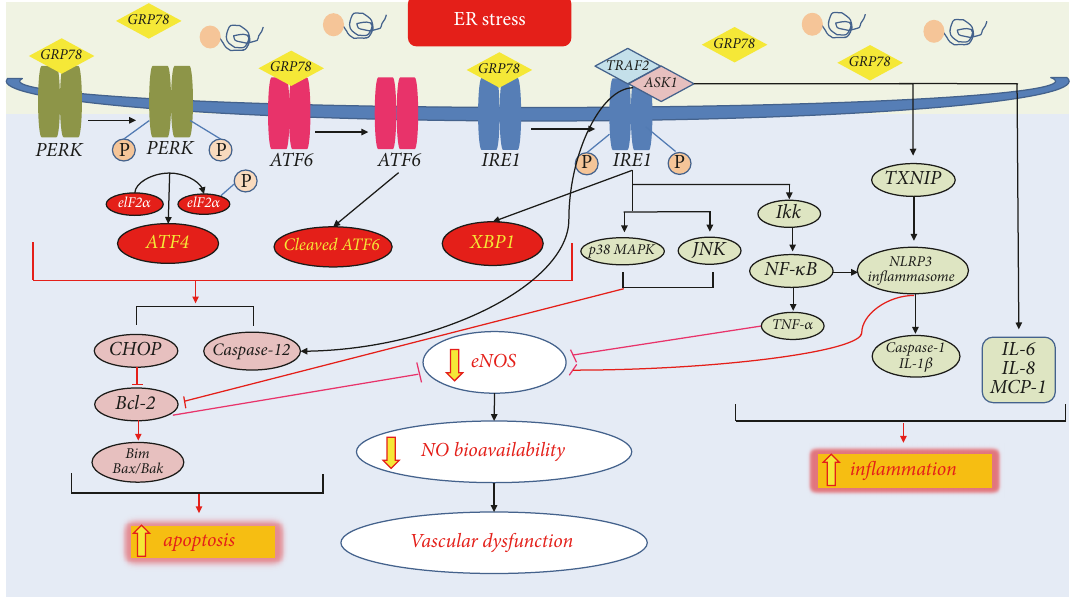
Figure 1: ER stress-mediated apoptosis and inflammation in cardiovascular disease . When prolonged ER stress occurs, activation of CHOP- mediated and JNK/p38 MAPK-mediated apoptosis signaling pathways regulate the Bcl-2 family, which controls the balance of pro- /antiapoptotic signaling, and ER stress-induced apoptosis signaling dampens eNOS expression with the increased oxidative stress. The IRE1 𝛼 /TRAF2/ASK1 complex also activates caspase-12 and ultimately induces cell apoptosis. Furthermore, ER stress-mediated NF- 𝜅 B-IKK activates NLRP3 inflammasome and mediates eNOS activity. Excessive ER stress and activation of the IRE1 𝛼 /TRAF2/ASK1 pathway increase TXNIP activation that subsequently induces NLRP3 inflammasome and reduced eNOS activity. The IRE1 𝛼 /TRAF2/ASK1 complex also contributestotheexpressionofproinflammationsthatstimulateNLRP3inflammasome-inducedcaspase-1andIL-1 𝛽 andUPR-mediatedIL-6. ER stress also activates IL-8, MCP-1, and TNF- 𝛼 expression. Ultimately, the accumulation of ER stress-mediated apoptotic and inflammatory responses decreases the eNOS activity which diminishes NO bioavailability and causes vascular dysfunction. The yellow arrows represent ER stress-mediated